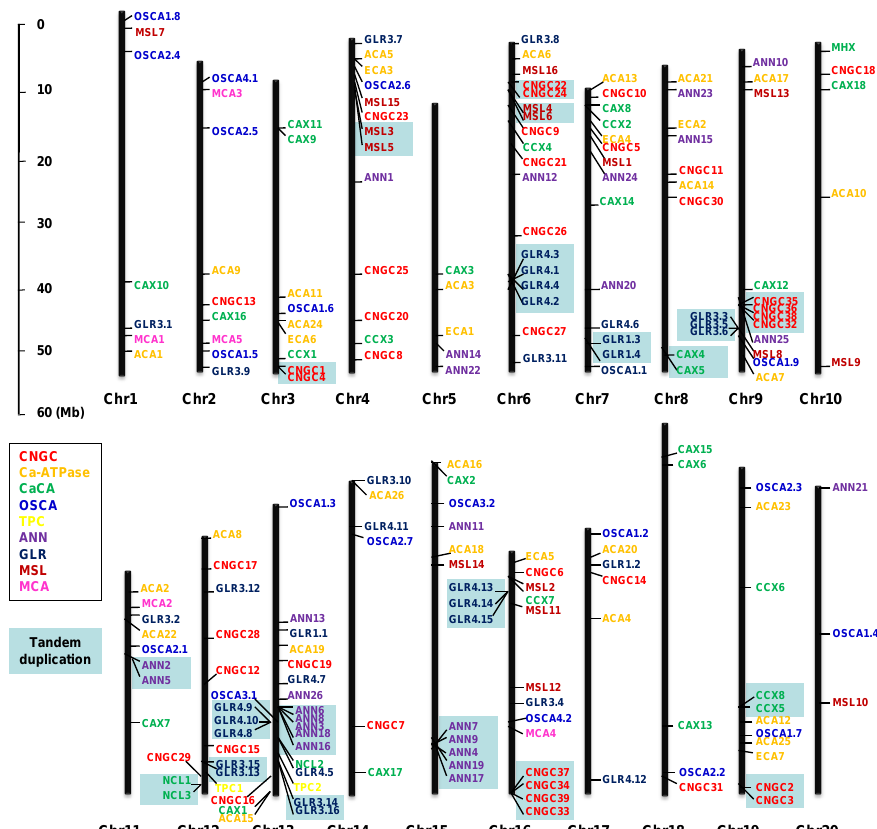
Figure 11. Graphical representation of locations for all the Ca 2+ transport genes on each chromosome of soybean. Genes within the same family were marked in the same color. Genes within a light blue box are putatively tandemly duplicated.